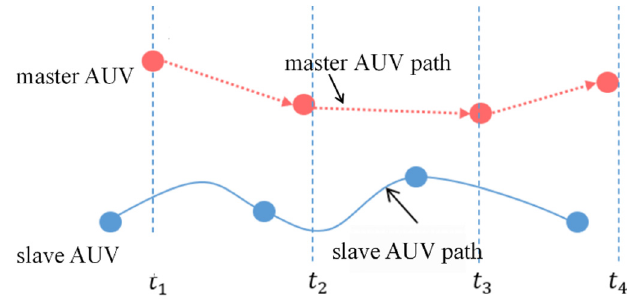
Figure 7. Schematic of multi-AUV cooperative navigation.